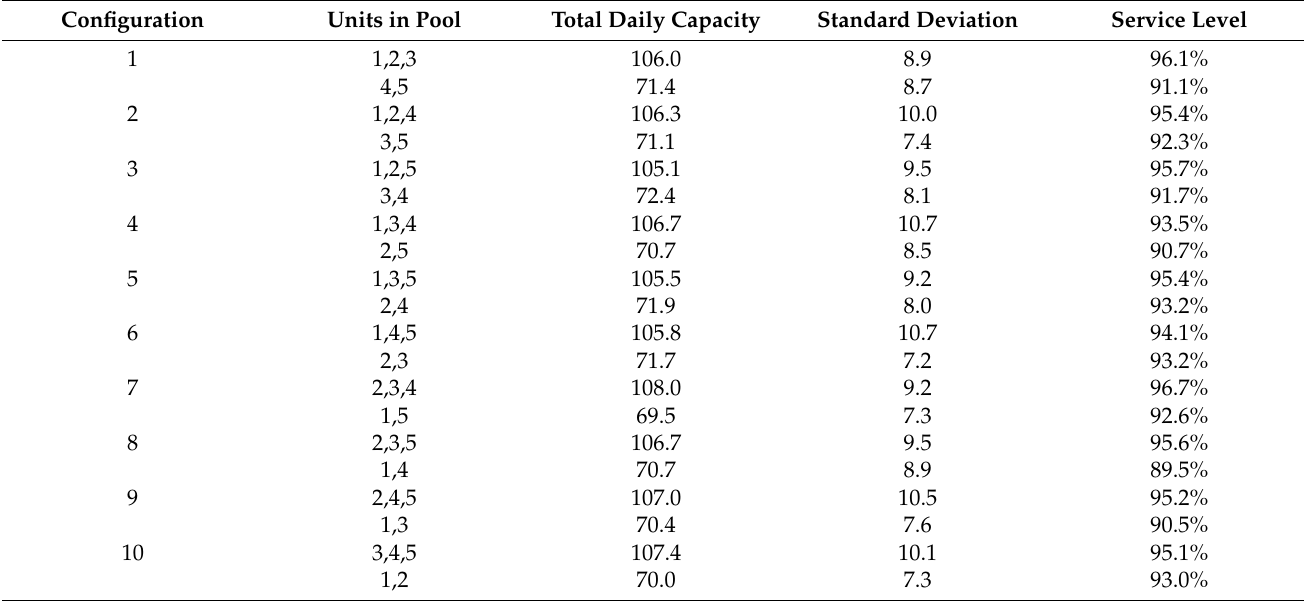
Table 3. Pool configurations and the resulting service